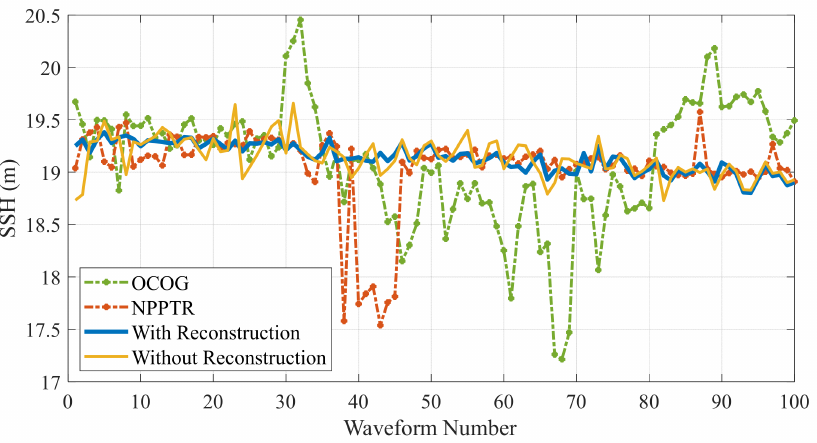
Figure 14. Retrieved SSH data for experimental area 2 of year